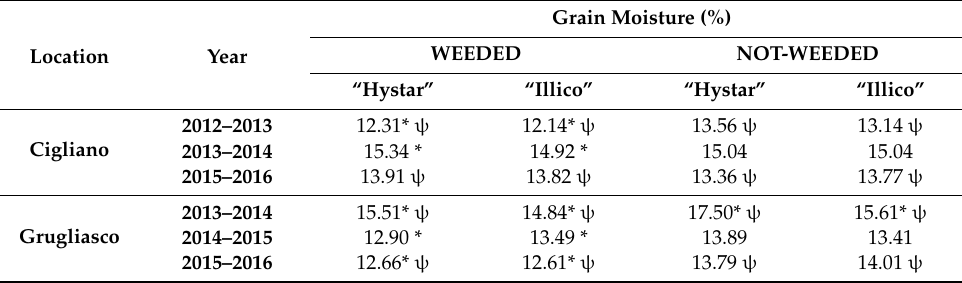
Table 8. Grain moisture measured at the harvest in the two